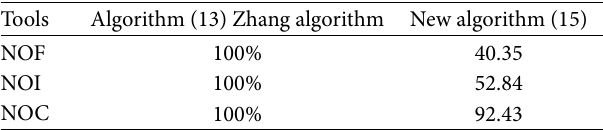
Table 1: Percentage performance of algorithm (15) against algorithm